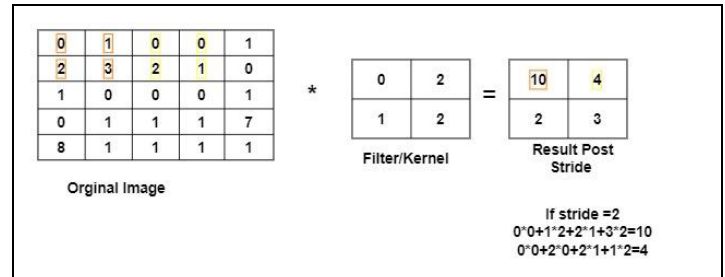
Figure 3. A Stride Example .